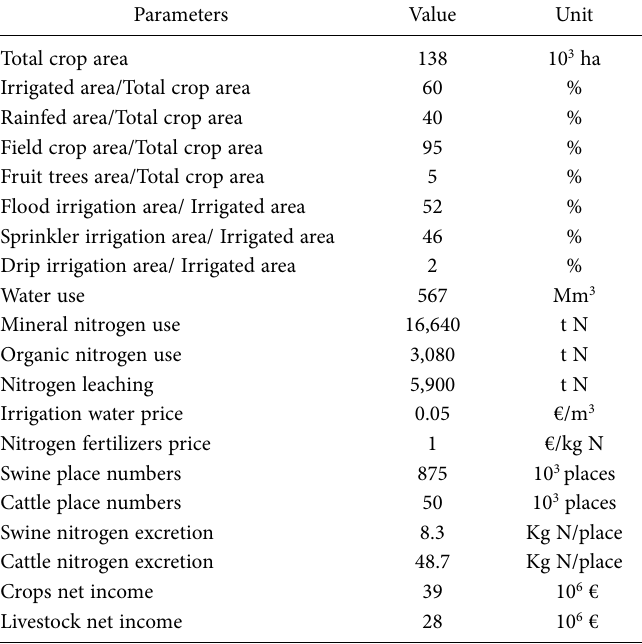
Table 1. Parameters of the